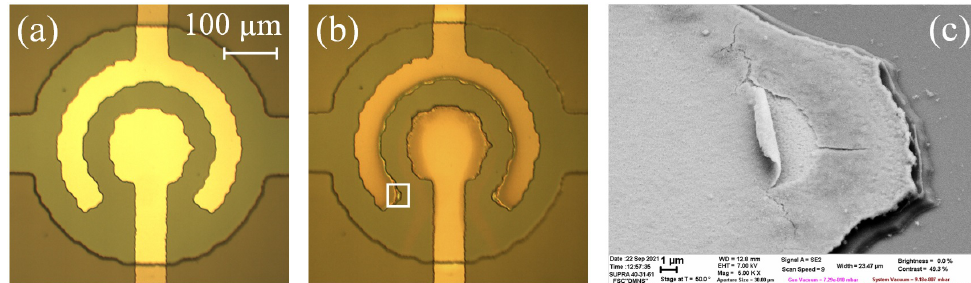
Figure 12. Working chamber of the actuator with the transparent membrane: ( a ) before the test; ( b ) after 60 min of operation in the current stabilization regime; ( c ) SEM image of the electrode edge marked by the white frame in image ( b